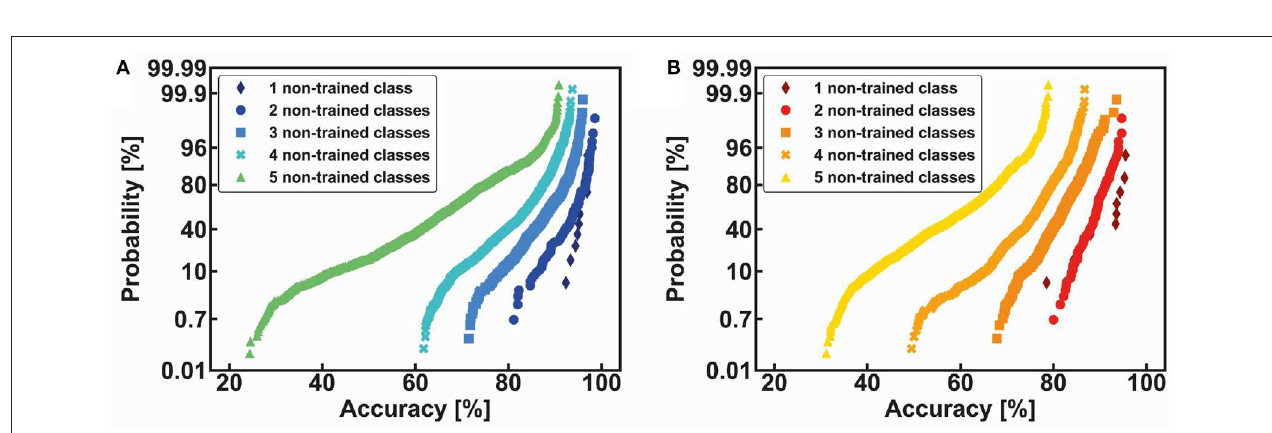
FIGURE 12 | Cumulative distributions of classification accuracy as a function of the increasing number of non-trained classes, from 1 to 5, for the MNIST (A) and the Fashion-MNIST datasets (B) .